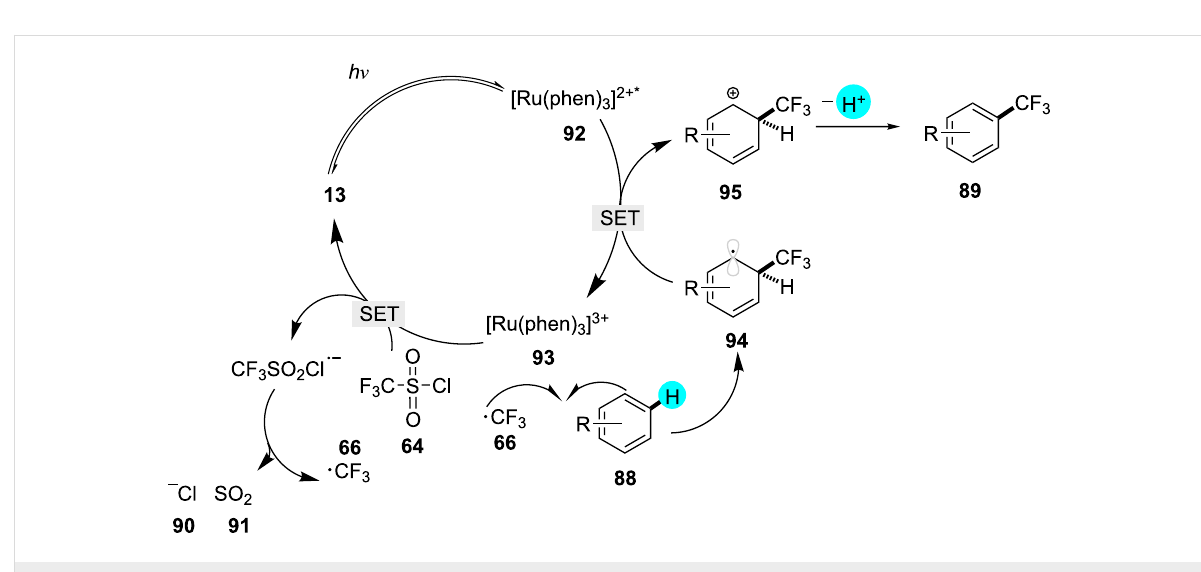
Figure 14: Proposed mechanism for the trifluoromethylation of 88 .